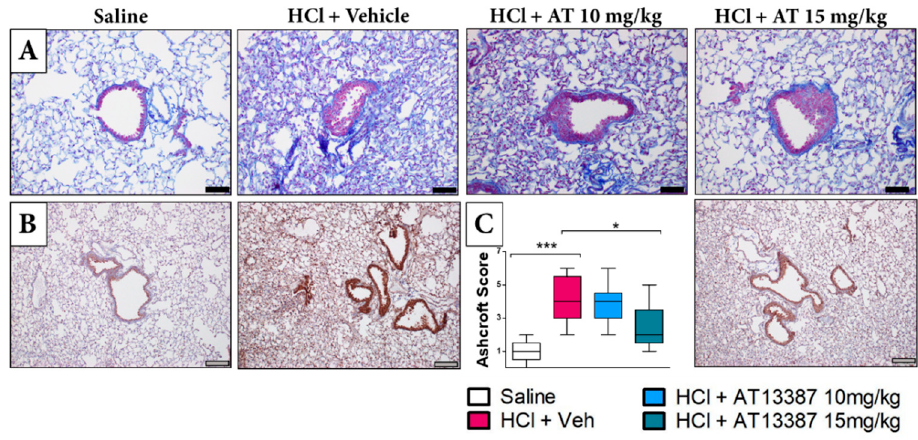
Figure 2. Subcutaneous treatment with AT13387 ameliorates pulmonary fibrosis. ( A ) Masson’s Trichrome staining of lung sections from mice instilled with vehicle (saline) or HCl and treated with AT13387 at 10 and 15 mg/kg or vehicle. ( B ) Immunohistochemical staining for the inflammasome NLRP3. ( C ) Quantification of chronic lung injury and pulmonary fibrosis performed by the Ashcroft score. Original magnification 10×–20×; black scale bars correspond to 50 µm, and grey scale bars correspond to 100 µ m. n = 5 mice per group; *: p < 0.05; ***: p < 0.001, with 1-way ANOVA and Tukey’s